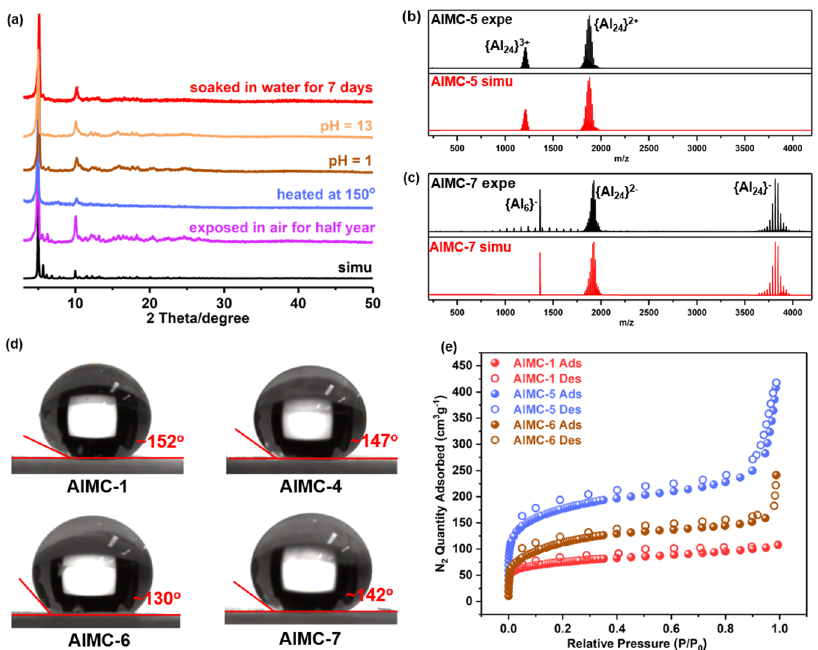
Fig. 4 | Stability, wettability, and porosity measurements on selected cages. a Structural stability of AlMC-1 under different conditions. b Solution stability of AlMC-5 : experimental and simulated mass spectra in MeCN under positive mode. c Solutionstabilityof AlMC-7 :experimentalandsimulatedmassspectrainamixed